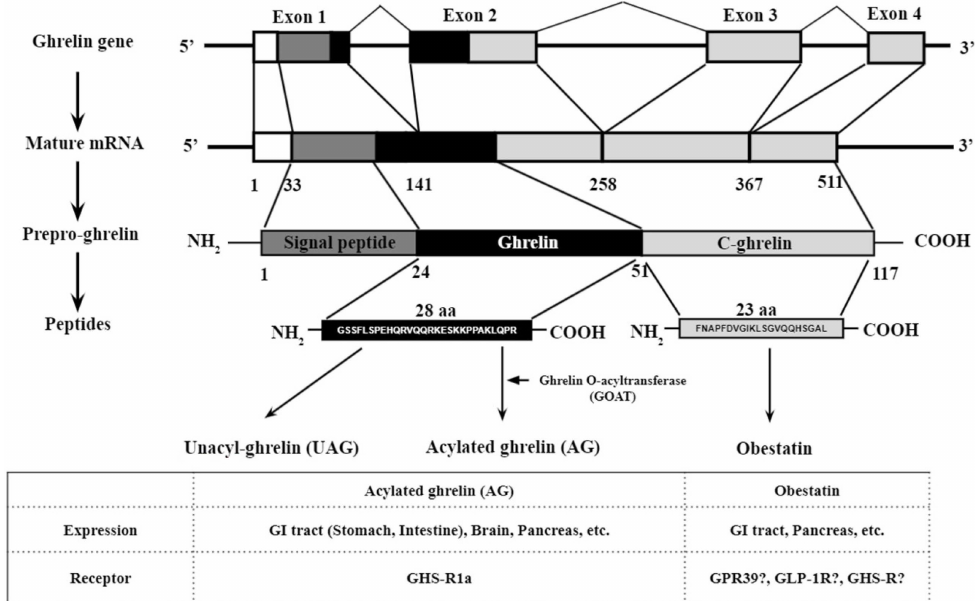
Figure 1. Post-translational processing of preproghrelin to unacyl ghrelin, ghrelin, and obestatin. The figure was modified from Delporte